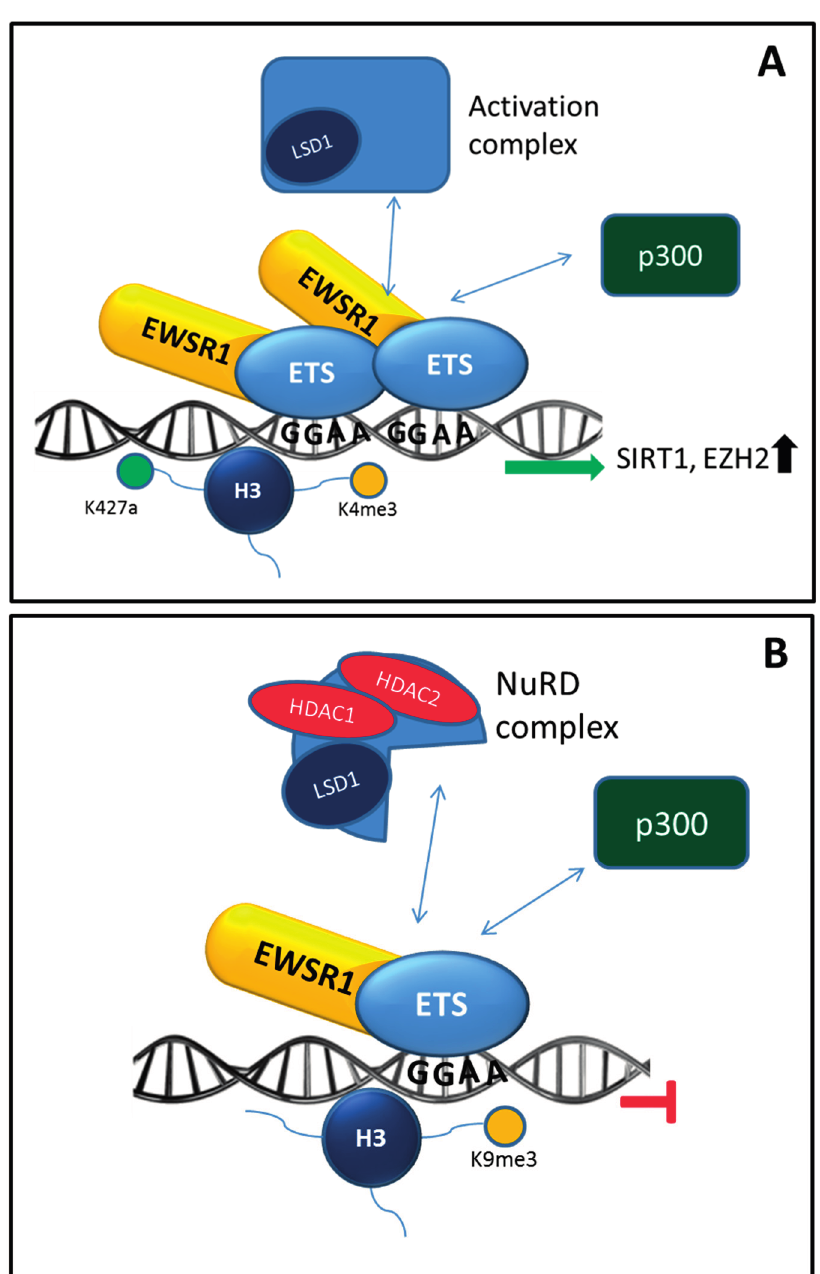
Figure 2. EWSR1-ETS mediated epigenetic activation and repression of gene expression. Possible mechanisms of how EWSR1-ETS acts as a transcription activator or repressor with different chromatin remodelers and is associated with different epigenetic histone modifications. ( A ) EWSR1-ETS activation complex binds to GGAA microsatellites. The complex attracts LSD1 in a yet unidentified activation complex and p300, which is needed for efficient transcription. The activation complex may bind to H3K4me3 and H3K27ac histone marks which, in turn, may lead to upregulation of the epigenetic modifiers SIRT1 and EZH2 ; ( B ) EWSR1-ETS repression complex binds to single GGAA elements and scavenges for p300, but, as it is insufficient to create an activating complex, it may recruit NuRD repression complex which may lead to further repressed expression. In addition, these repression sites are marked with H3K9me3 histone